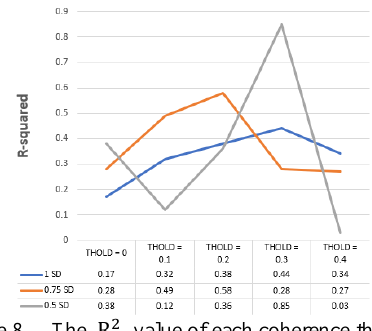
Figure 8. The R 2 value of each coherence threshold